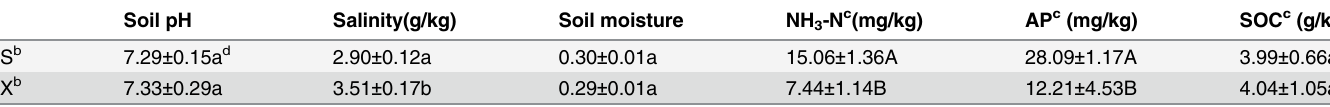
Table 3. Basic physical and chemical properties of the sampling zones a